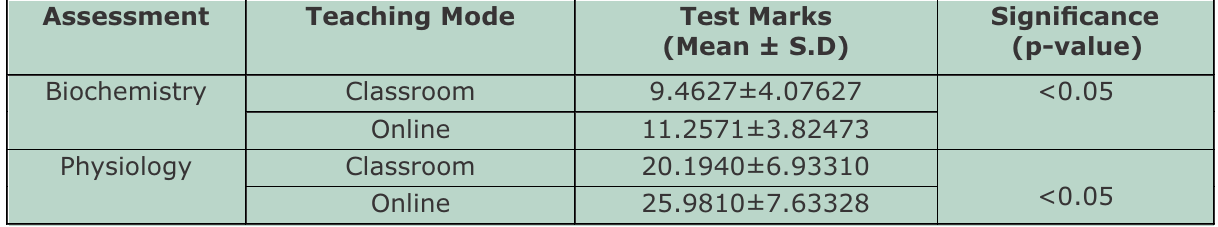
Table - I: Comparison of test marks between Classroom & online